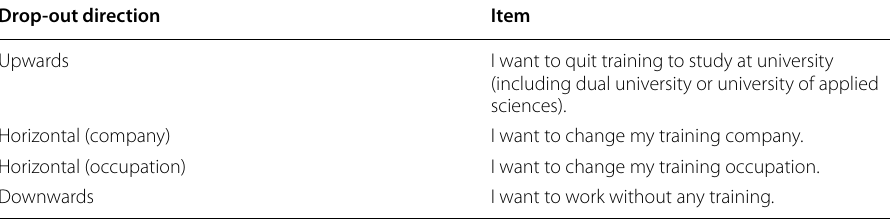
Measured on a five‑level Likert scale (0